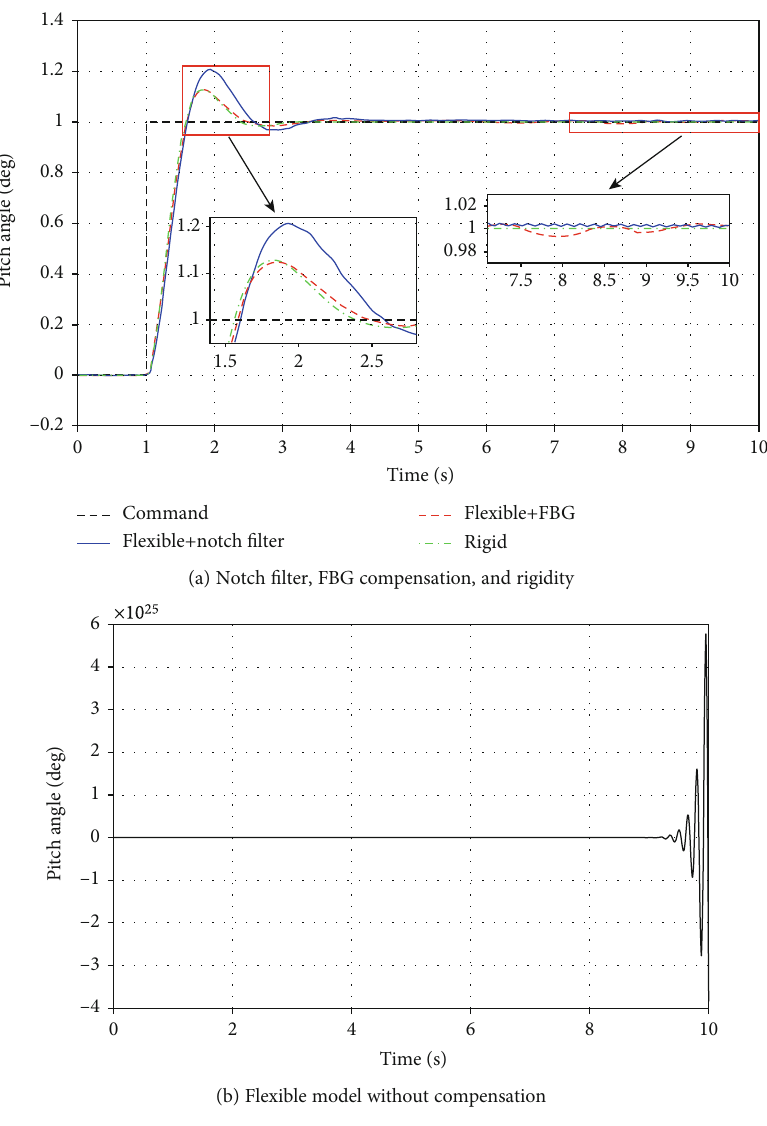
Figure 15: Pitch angle response